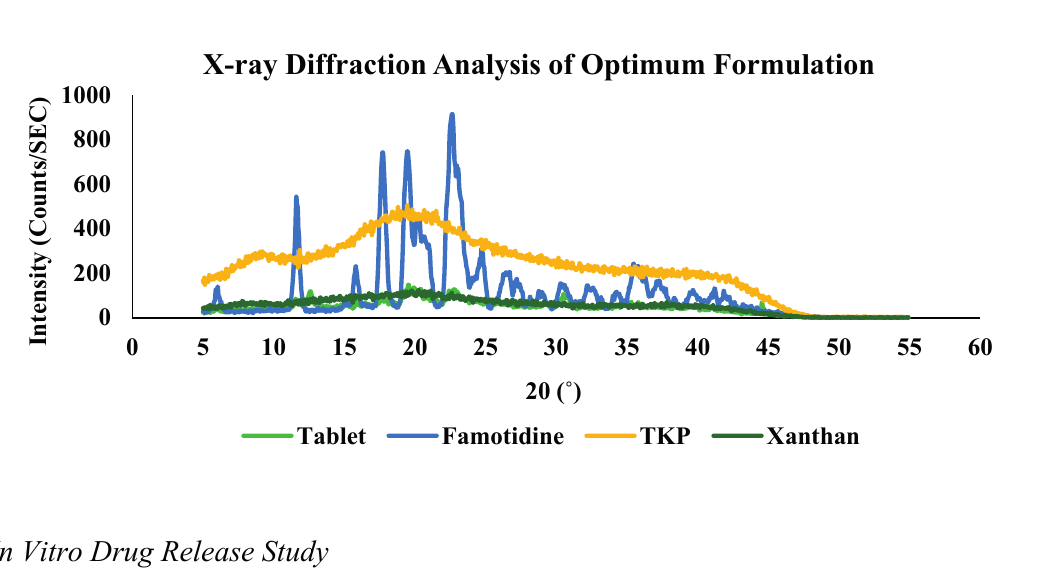
Figure 9. X-ray diffraction of pure famotidine, TKP, xanthan and crushed optimum matrix tablet of